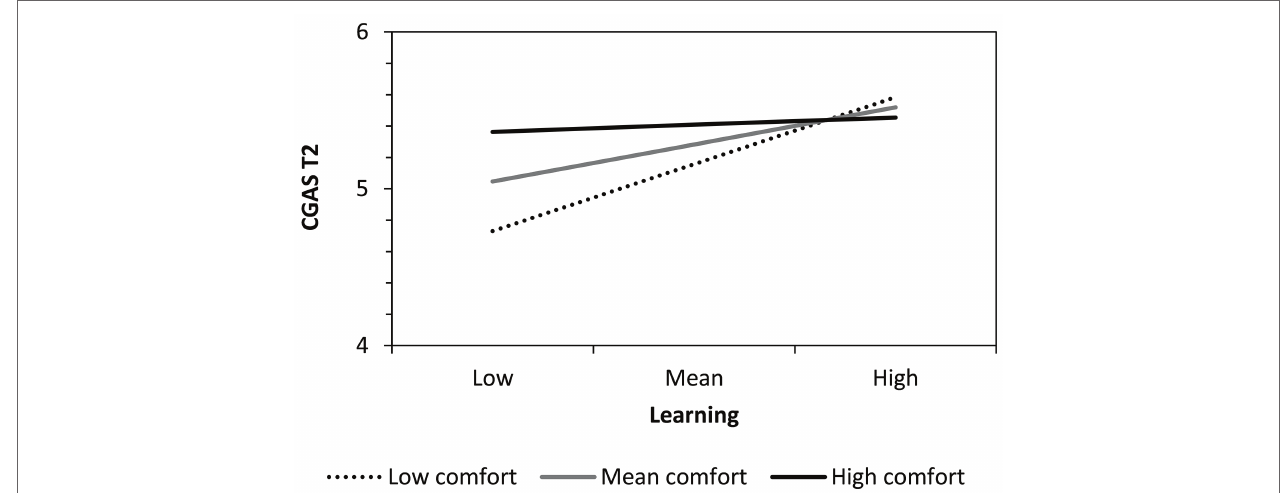
FIGURE 2 | Comfort-moderated effects of learning experience during the LSEP on T2 cross-generational age stereotyping (CGAS; after controlling for autoregressive T1–T2 effects).